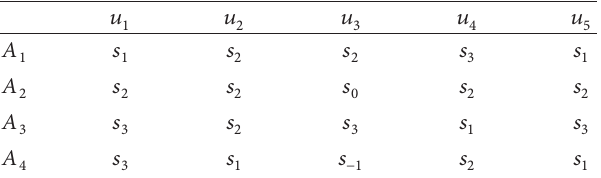
Table 3: The evaluation values of four alternative hubs given by expert 𝑑 3